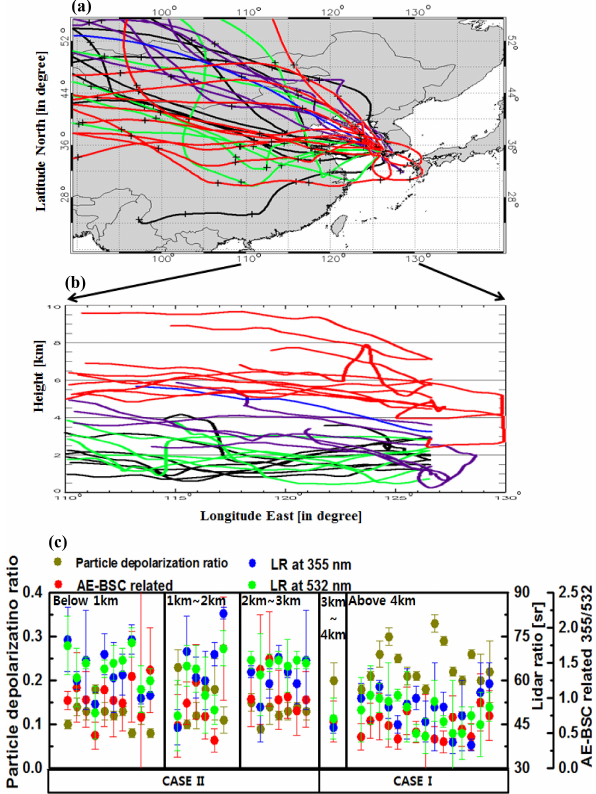
Figure 8. (top panel) (a) transport path and classification of East Asian dust layers with respect to (b) their altitude above ground when they passed over industrial regions of China. Bottom panel: transport path and corresponding altitude of Asian dust layers are distinguished by color (black: 0–1km; green: 1–2km; purple: 2– 3km; blue: 3–4km; red: above 4km). Scatterplots of the linear par- ticle depolarization at 532nm (dark yellow), the backscatter-related Ångström exponent (355/532nm wavelength pair, red), the lidar ra- tio at 355nm (blue), the lidar ratio at 532nm (green) depending on the five altitude categories (c) . The height of the Asian dust layers above ground is separated by vertical lines. Case I included the lay- ers from 3 to 4km and above 4km. Case II includes the layers from 0 to 1, 1 to 2, and 2 to 3km height above ground.